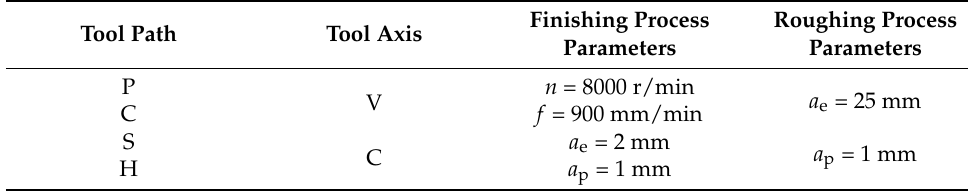
Table 1. Finishing process simulation